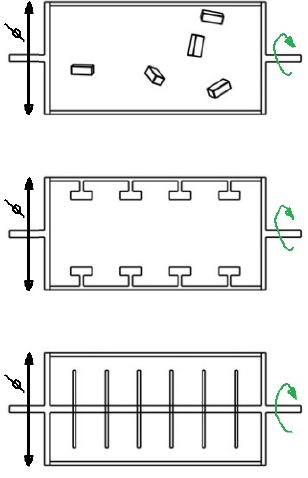
Figure 6. Types of rotation-based bioreactor systems.